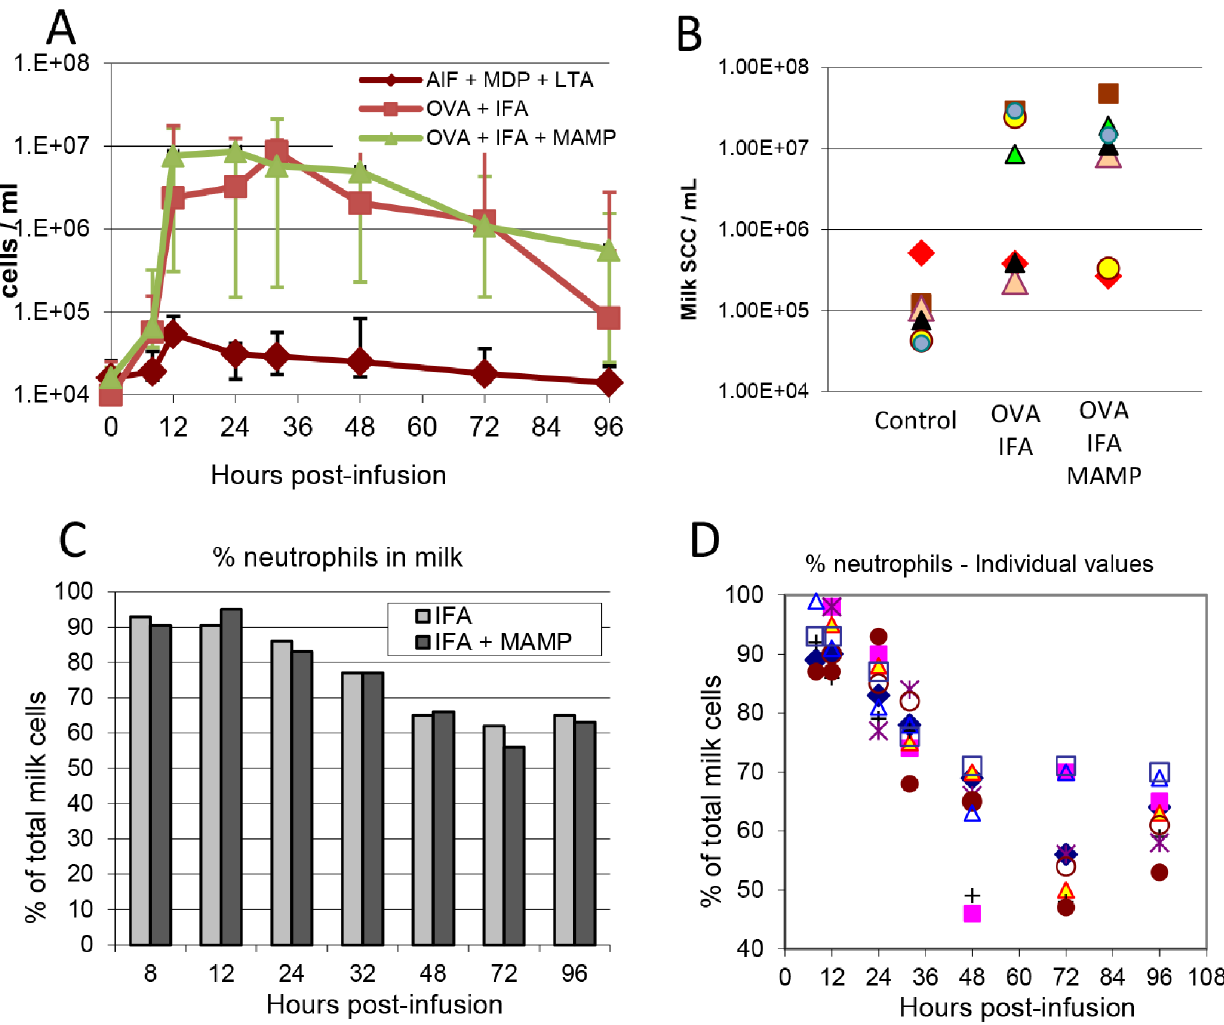
Figure 2. Influx of leukocytes following the intramammary challenge of 21 cows with ovalbumin. A) Kinetics of cell concentrations in milk of unimmunized control cows, cows immunized with ovalbumin in incomplete Freund adjuvant, or cows immunized with ovalbumin in IFA supplemented with MAMP (MDP and LTA) (n=7 per group); B) Individual values of milk cell concentrations at the peak of the cellular recruitment (3 6 7 cows); C) percentage of neutrophils (median values), determined by examination of cytospin slides stained with May-Gru¨nwald-Giemsa, of the cows that reacted following immunization with ovalbumin in IFA (IFA; n=4) or immunization with ovalbumin in IFA supplemented with MAMP (IFA + MAMP; n=5); D) Kinetics of the individual values of the 9 immunized cows that reacted to ovalbumin challenge without distinction of